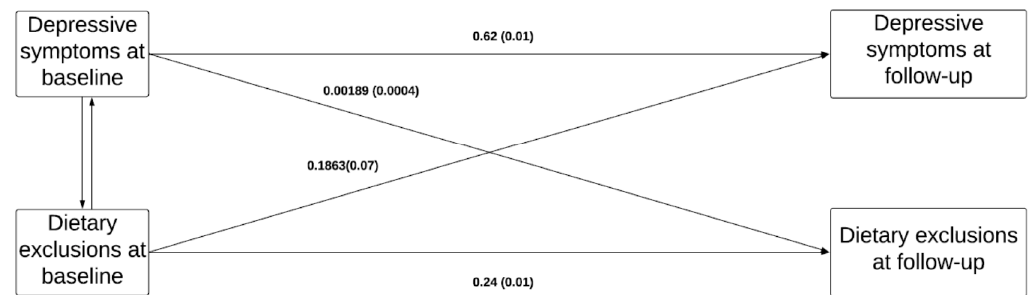
Figure 1. Depressive states defined by a Centre of Epidemiologic Studies-Depression (CES-D) score and analyzed as a continuous variable. Dietary exclusions defined as the number of exclusions and analyzed as a continuous variable. Fit statistics: CFI = 0.99, TLI = 0.99, RMSEA =